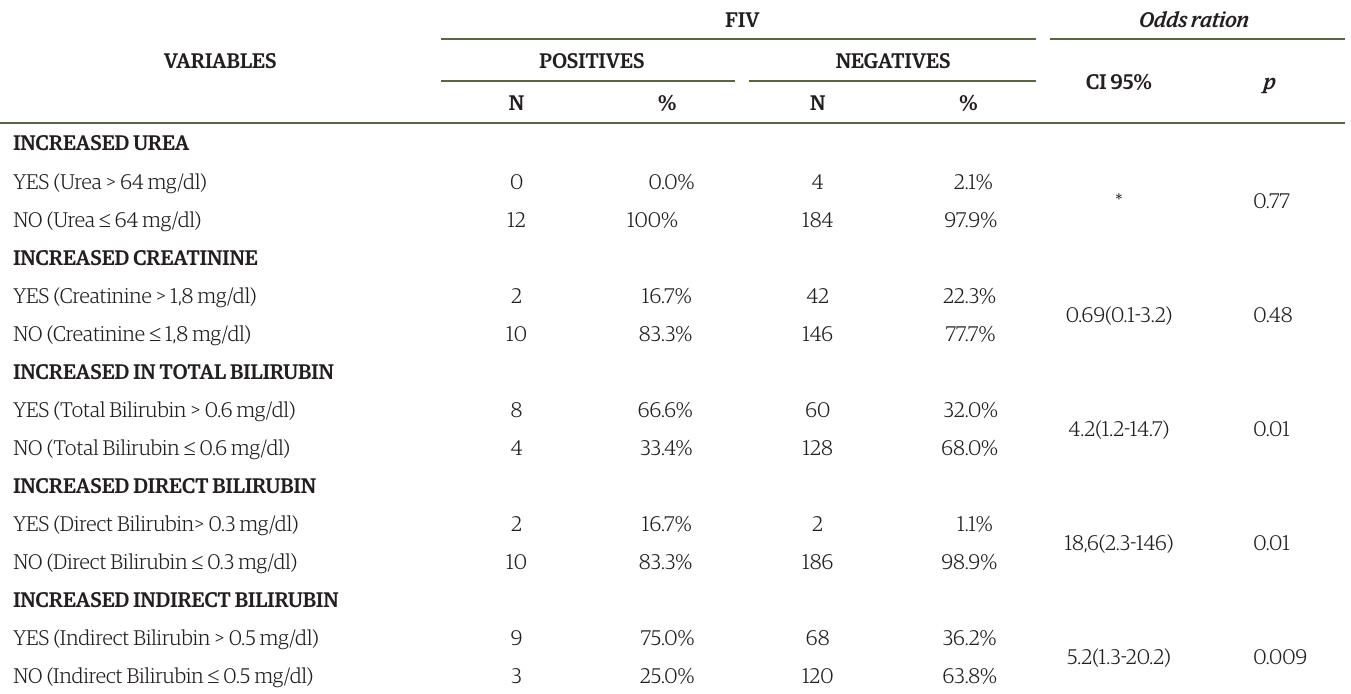
Lacerda et al. 2020. Brazilian Journal of Veterinary Medicine, 42, e110020. DOI: